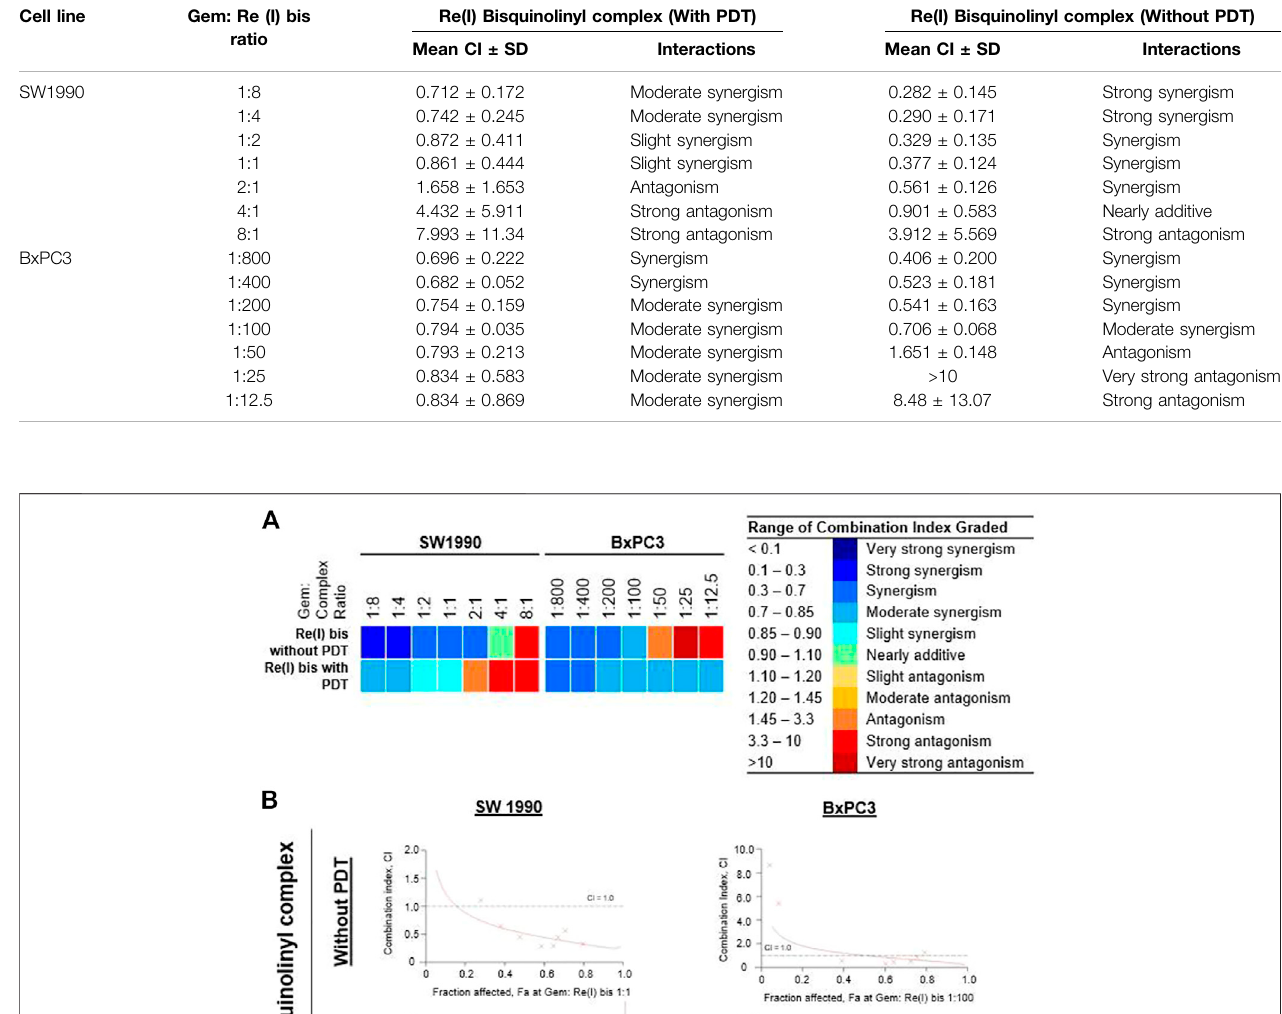
Frontiers in Pharmacology |